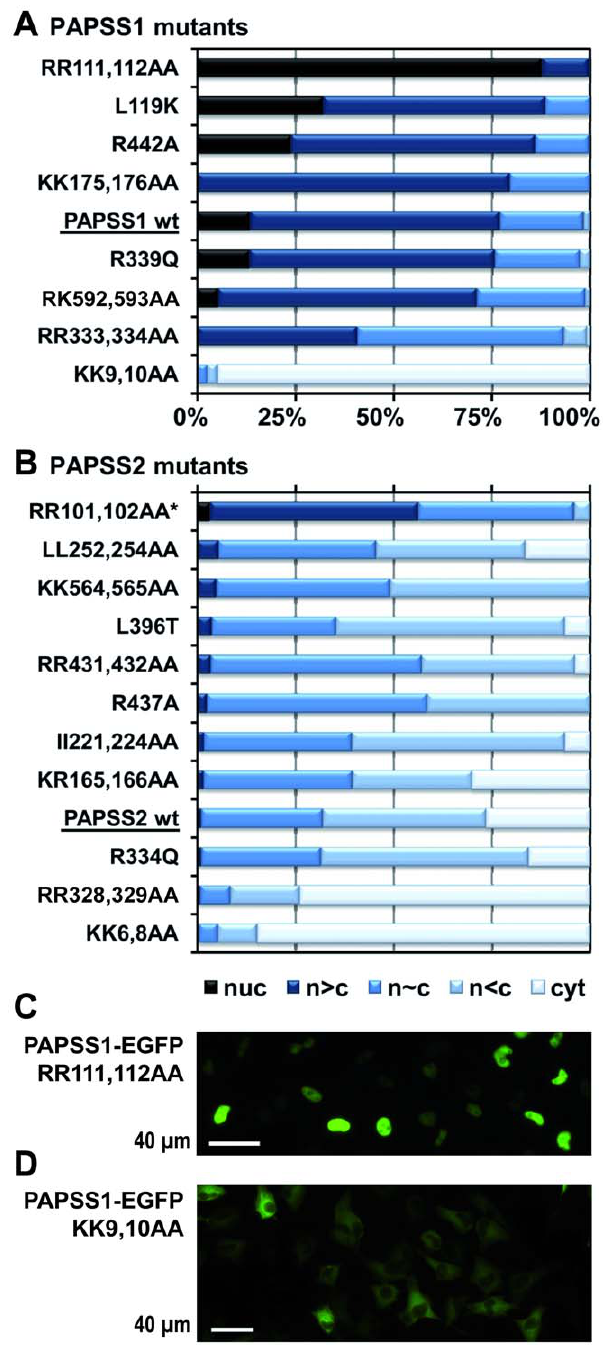
Figure 4. Mutation screen for localisation signals in PAPS synthases. A and B , phenotype of all mutants evaluated in this study for PAPSS1 and -S2. Potential NLS and NES signals were targeted by alanine mutagenesis. This also included the putative NESs around Ile221/Ile224 and Leu252/Leu254 in PAPSS2. At least 200 cells were scored for each mutant. All mutants are arranged according to the sum of the two fractions ‘‘nuc’’ and ‘‘n . c’’. *This mutant was evaluated in a DsRed mono context due to very weak expression of the respective EGFP fusion protein. C and D , microscopic images of PAPSS1-EGFP RR111,112AA as well as PAPSS1 KK9,10AA showing the strong and nearly uniform phenotype of these two mutants.